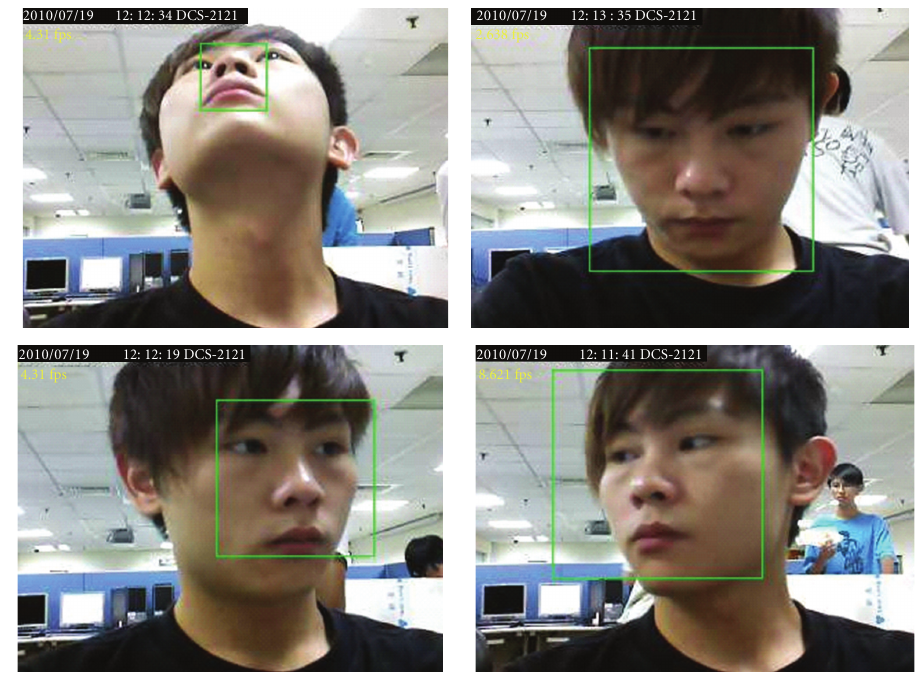
Figure 13: The limit angle of face